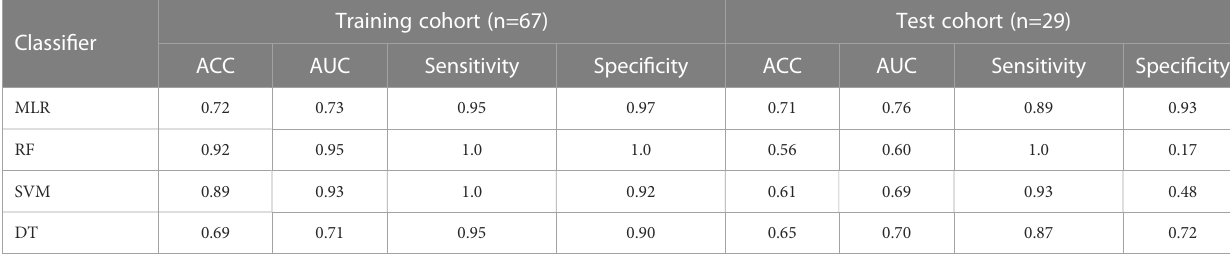
TABLE 4 Classi fi cation performance of different classi fi